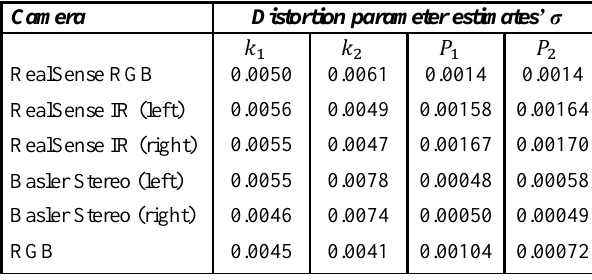
Table 3: Standard deviations of radial and tangential distortion model parameters.